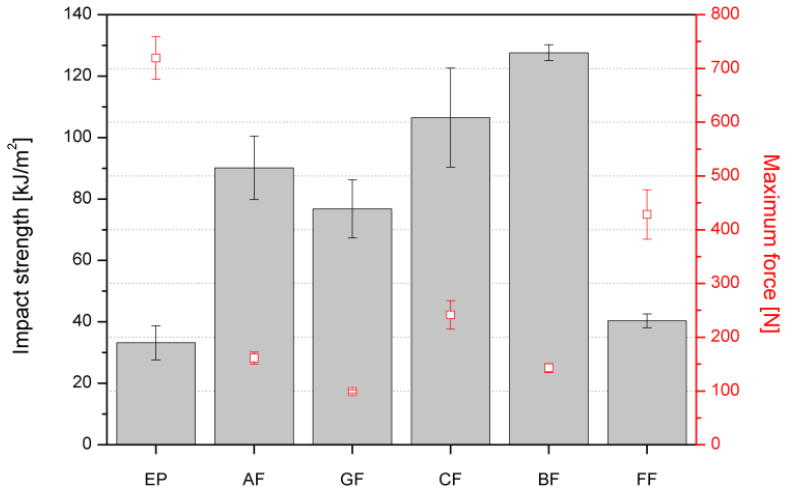
Figure 10. Charpy impact strength and corresponding measured Fmax during the test of the EP and EP-based composites.